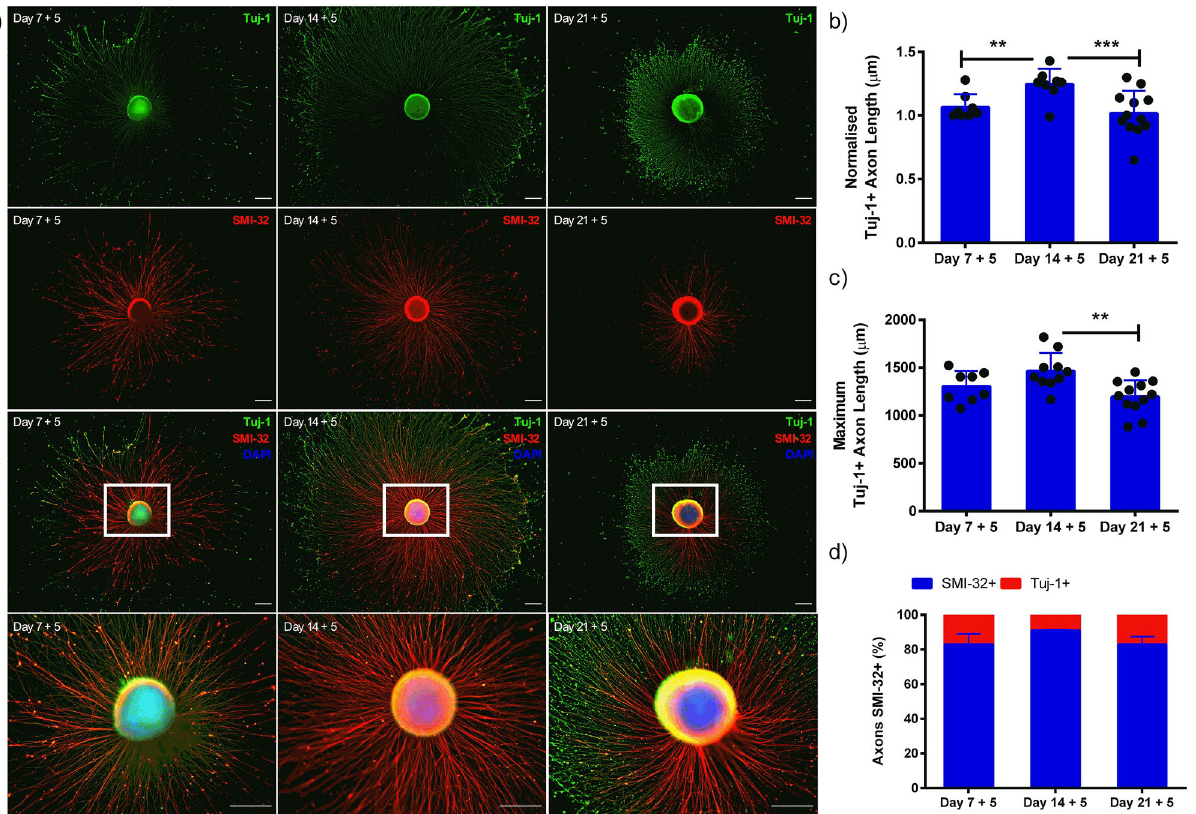
Figure 2. Axon extension of iPSC motor neuron spheroids is influenced by developmental stage. (a) Motor neuron progenitors cultured as 3D spheroids at different stages of development (7, 14 and 21 days) adhered in monolayer culture extend axons over 5 days, e.g. nomenclature ‘7 + 5’ denotes 7 days spheroid culture followed by 5 days adhered monolayer culture. (b) Tuj-1 positive (+) axon length after 5 days adherent culture following seeding at days 7, 14 and 21 days of maturation. Axon length data normalised to day 7 + 5 time-point. ( c ) Maximum Tuj-1 axon lengths (µm) at each stage of maturation. (d) Percentage (%) axons positive for mature heavy neurofilament SMI-32 after 5 days adherent culture at different development stages. Data indicative of minimum n = 8 per time-point and presented ± standard deviation (SD). **P ≤ 0.01, and ***P ≤ 0.001. Scale bars = 200